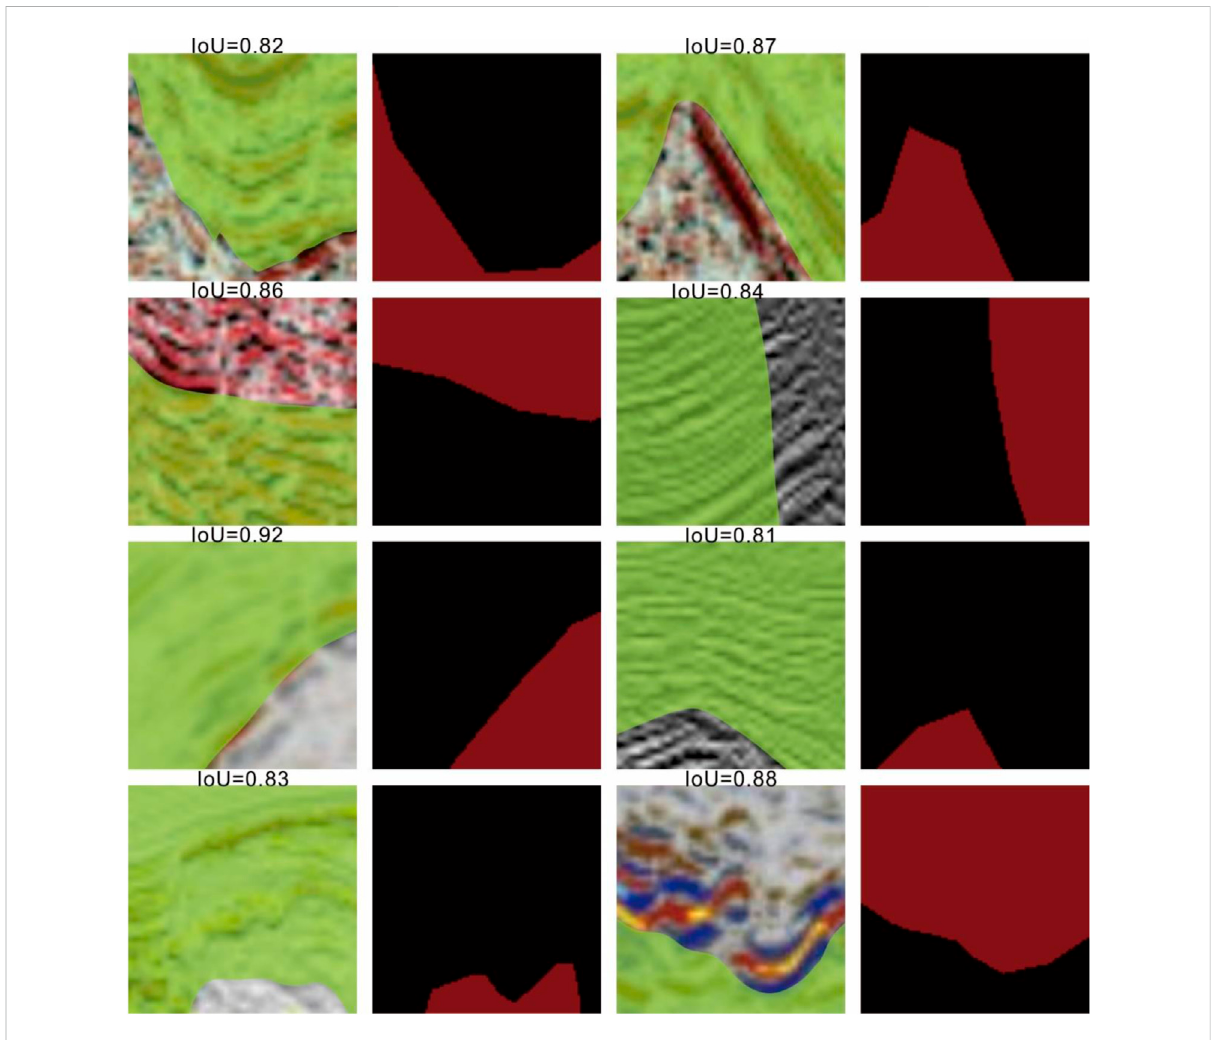
FIGURE 7 The stage 2 performance for background detection, with intersection over union (IoU) values (the green part is the background; in the segmented images, the red part is the salt structure and the black part is the